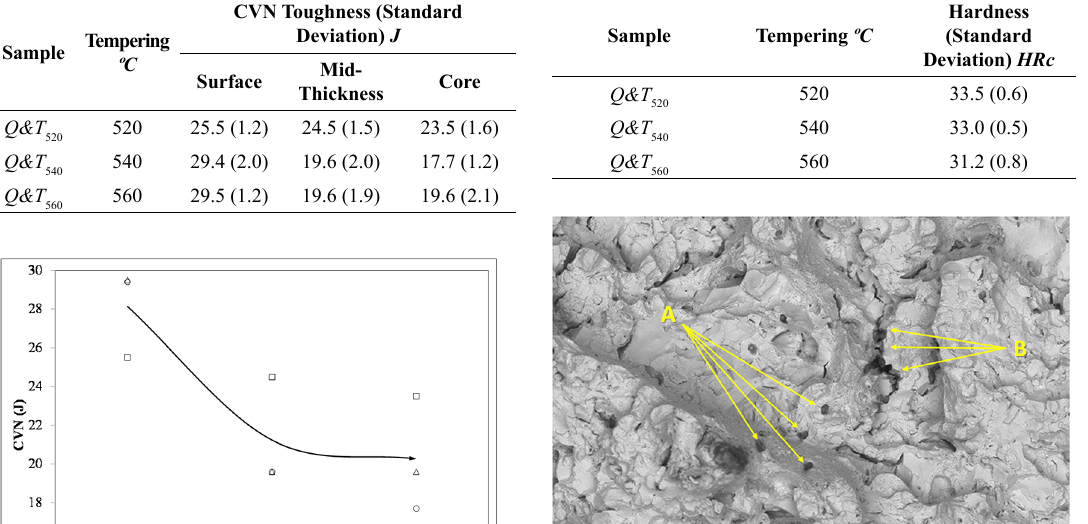
Figure 10. SEM/BSE image of fracture surface from CVN specimen from sample Q&T . Indication of the large borocarbide particles. 520